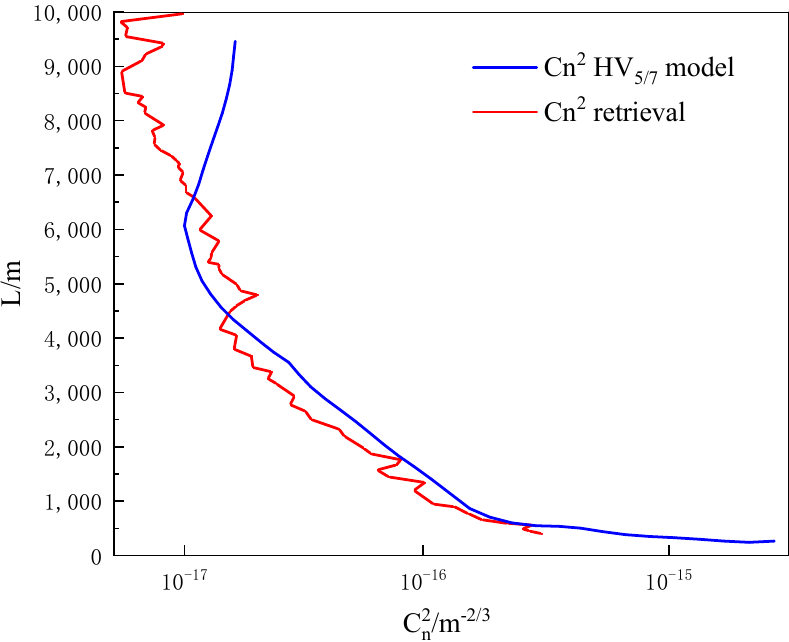
Figure 13. The profile of atmospheric refractive index structure constant obtained by the iterative inversion algorithm.